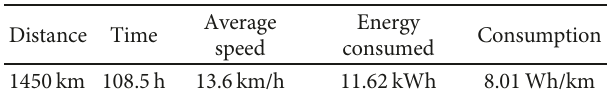
Table 3: Electric consumption data from CIEMAT headquarters